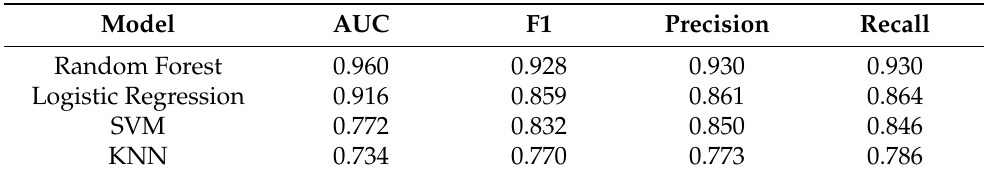
Table 3. Predictability of evaluation model.